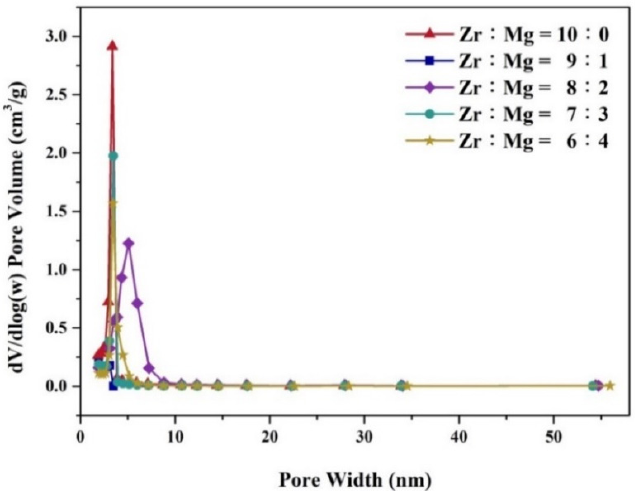
Figure 4. The pore size distribution of the as-prepared Zr–Mg mixed oxide aerogels with different Zr/Mg molar ratios. Table 1. The average pore diameter and specific surface area of the as-prepared Zr–Mg mixed oxide aerogels with different Zr/Mg molar ratios.